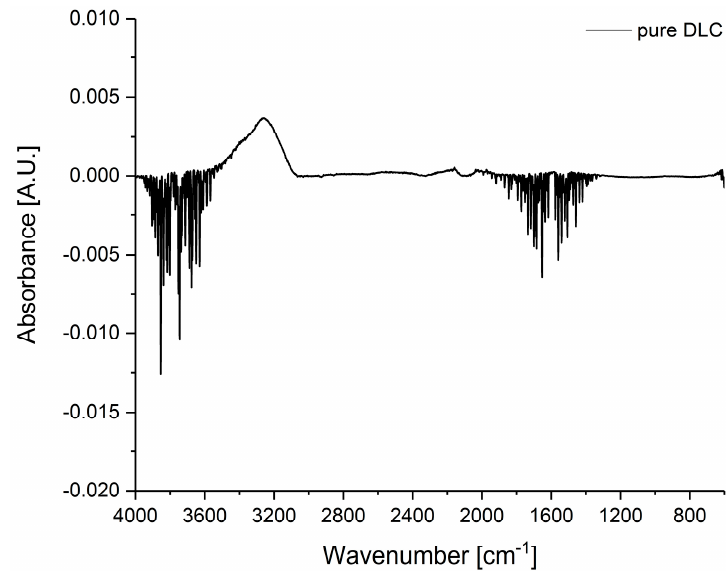
Figure 1. MIR spectrum of a cleaned pure diamond-like carbon (DLC) chip with air as background spectrum. Only absorption bands from water are visible.